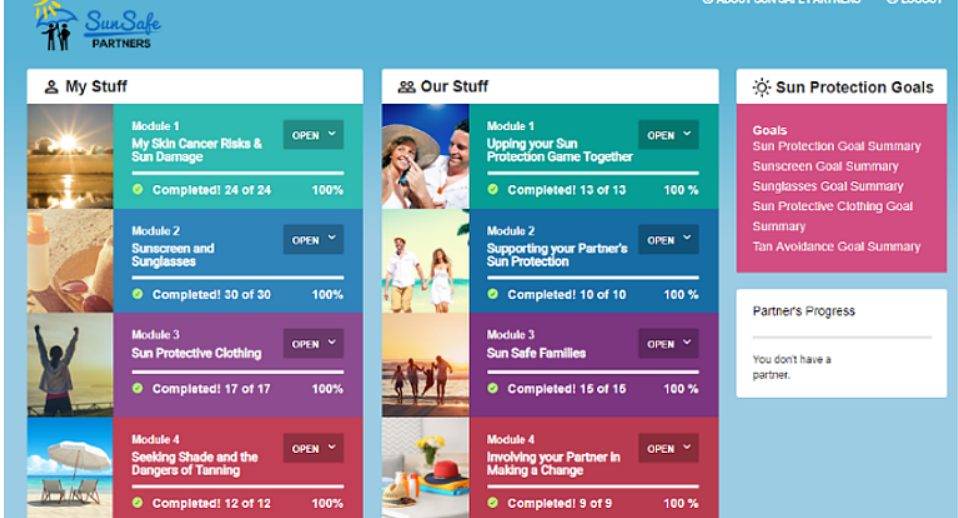
Figure 1. Sun Safe Partners’landing